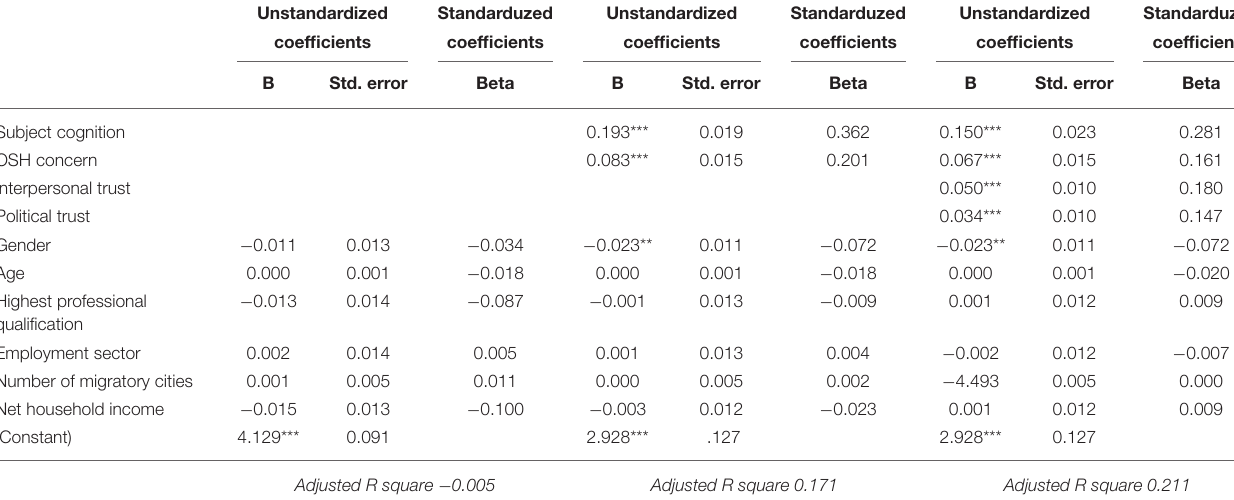
TABLE 5 | Parameter estimates for the regression analyses.